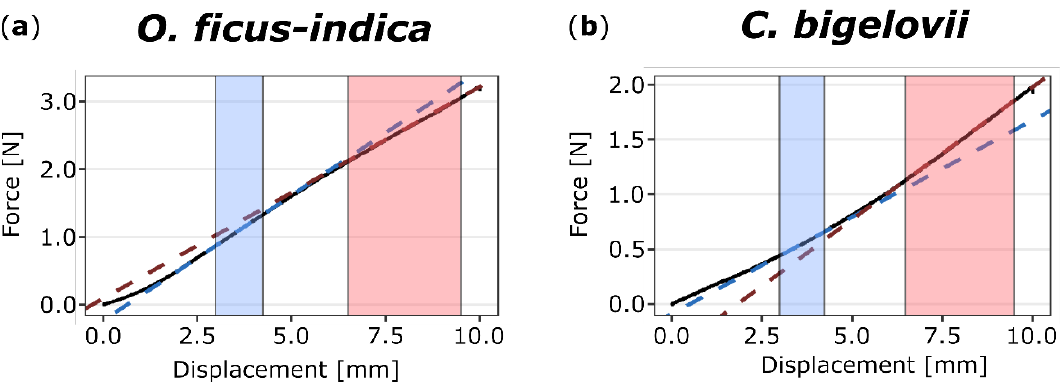
Figure 3. Exemplary force-displacement diagrams of two-point bending tests on (unwounded) branches of Opuntia ficus-indica ( a ) and Cylindropuntia bigelovii ( b ). The sections (colored background) and linear regression lines (colored dashed lines) of the first (from 3.0 to 4.25 mm, blue) and second (from 6.5 to 9.5 mm, red) linear ranges are highlighted. For O. ficus-indica , a decrease of slope from the first to the second range is visible, whereas for C. bigelovii , the value increases. Table 1. Mean values ± standard deviation (SD) of bending stiffness ratios in various states for Opuntia ficus-indica and Cylindropuntia bigelovii . These values quantify the stiffening (ratio > 1) or softening (ratio < 1) of the tissues between the first and second linear range.